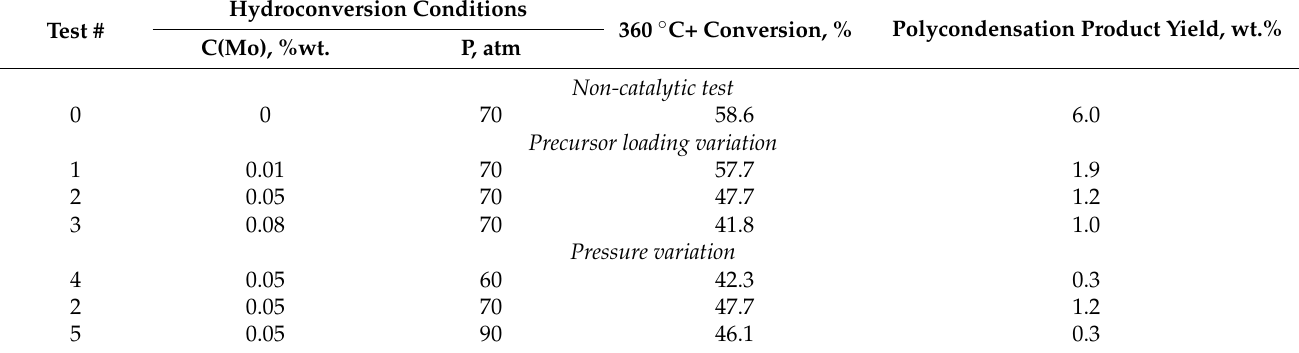
Table 1. Results of bituminous oil hydroconversion in the presence of in-situ synthesized Mo-containing catalyst (catalyst precursor-ammonium paramolybdate, water content in feed emulsion − 2%wt., hydroconversion conditions: T = 450 ◦ C, H 2 /feed = 1000 nL/L, V = 1.0 h − 1 , once-through